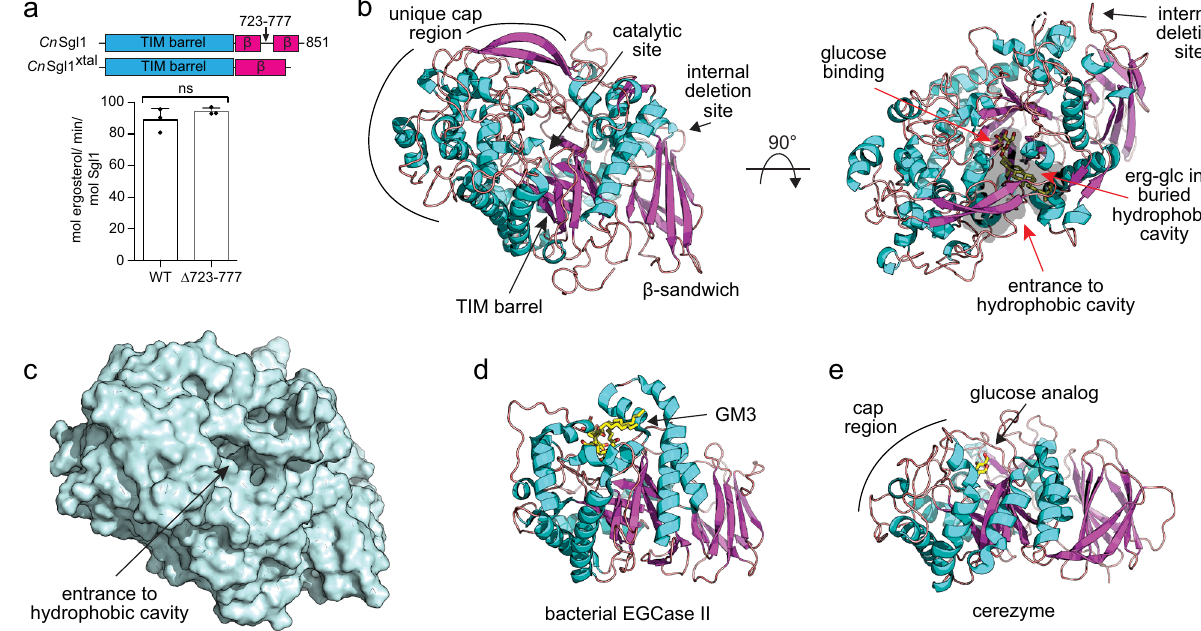
Fig. 2 Overall structure. a The deletion of 55 residues in C. neoformans (Cn) Sgl1 xtal ( Δ 723 – 777) does not affect Cn Sgl1 activity towards erg-glc. Data represent the mean ± SD for n = 3 independent experiments. Statistical analysis by one-way ANOVA, Dunnett ’ s multiple comparison test. b Structure of Cn Sgl1. Cn Sgl1 is organized in two domains: a TIM barrel containing the catalytic site and a C-terminal β -sandwich domain. A unique cap region encloses the active site to form a Y-shaped cavity (gray outline, visualized using pymol internal surface cavity) for erg-glc binding. Docked erg-glc is shown in yellow with the ergosterol moiety bound in the enclosed hydrophobic cavity. c Surface representation of Cn Sgl1 showing the entrance to the hydrophobic cavity of the buried active site. d Bacterial EGCase II (pdb code: 2OSX) conserves the two domain architecture but has a solvent-exposed active site to hydrolyze gangliosides with more than one sugar. e Recombinant human glucosylceramidase, cerezyme (pdb code: 6TJQ) presents similarities with Sgl1, including a small cap region; however, its active site is solvent exposed and does not contain a buried cavity. Source data are provided as a Source Data fi (Table 1). The deleted region between residues 723 and 777 is not conserved among Sgl1 orthologs (Supplementary Fig. 3) and appears speci fi c for C. neoformans Sgl1 with no obvious role in Sgl1 function or regulation. Phases were determined using single wavelength anomalous diffraction from selenomethionine- enriched protein (Table 1).